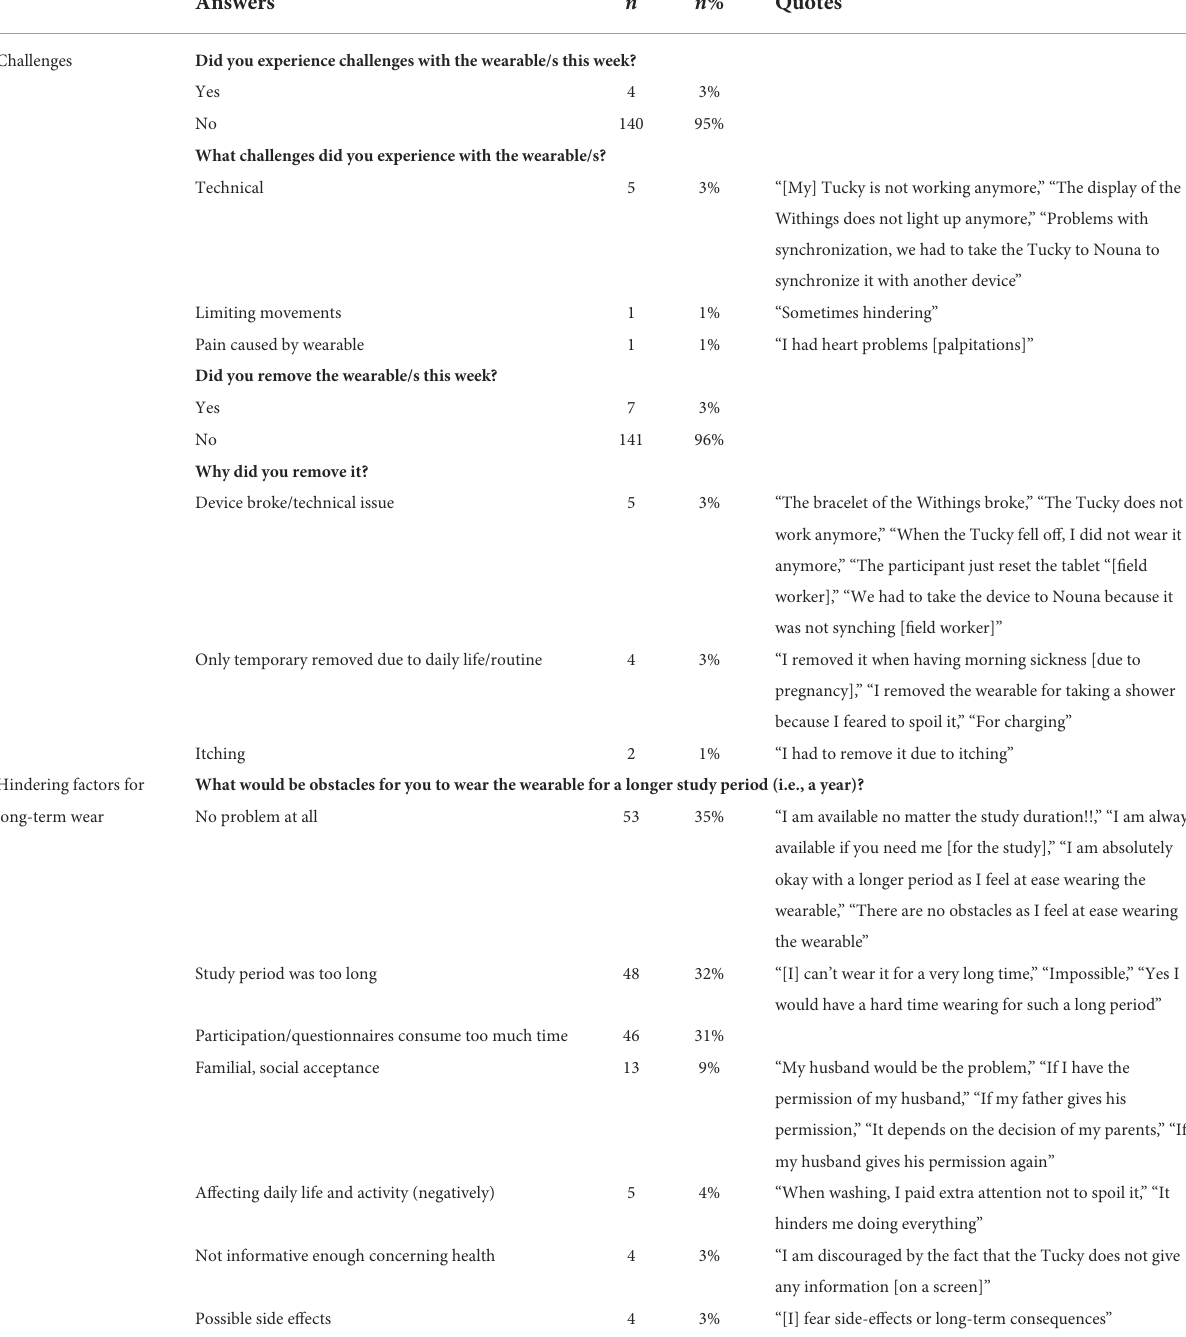
TABLE 4 Overview of key responses to multiple-choice and open-ended questions about experienced challenges with the wearables, and hindering factors for a possible long-term study with wearables. Answers n n %